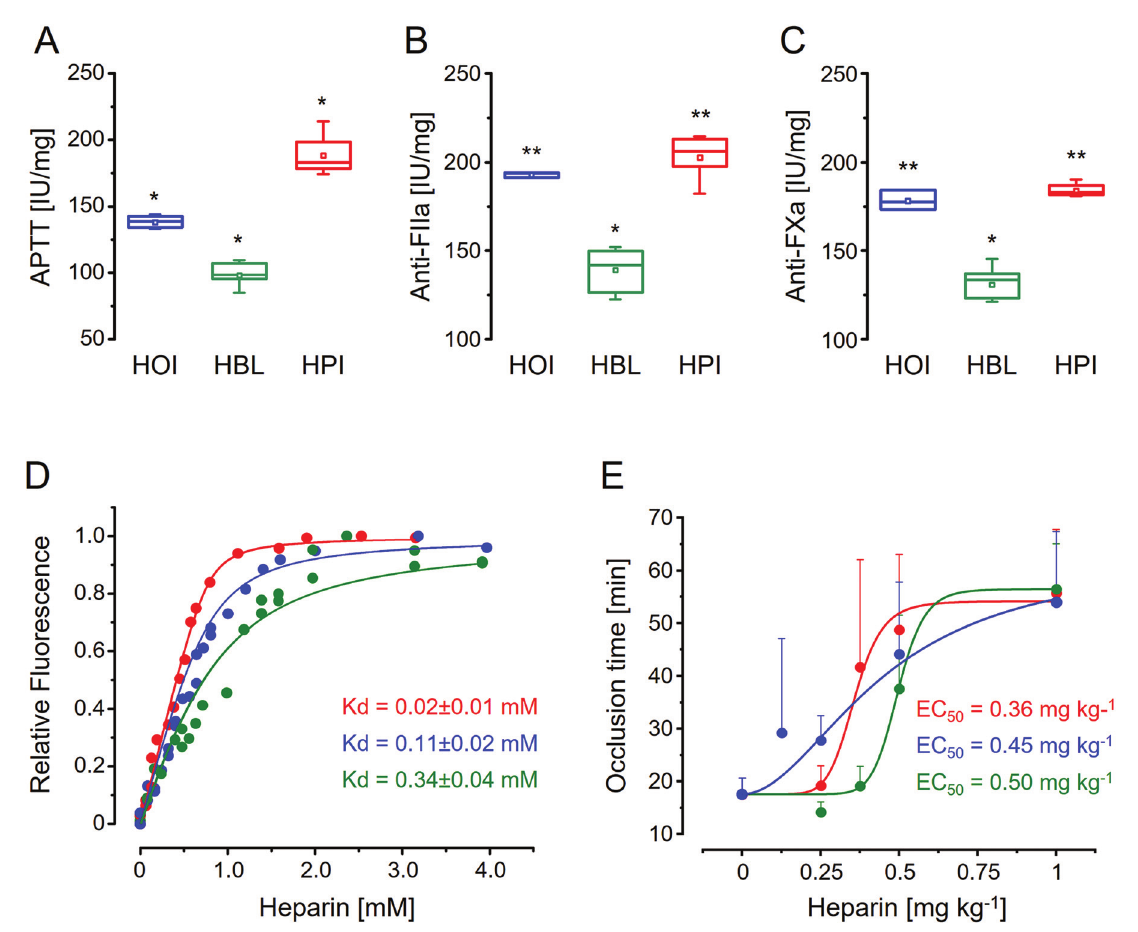
Fig. 7 Heparins obtained from different source have distinct anticoagulant and/or antithrombotic activities. APTT (A), anti-FIIa (B) and anti-FXa (C) assays of HOI, HBL and HPI (in blue, green and red, respectively, in all panels). (D) Fluorometric analyses by titration of the different heparins with antithrombin performed to calculate their dissociation constants (K d ). (E) Antithrombotic activities (EC 50 ) of the different heparins in an animal model of venous thrombosis based on the determination of occlusion time of the jugular vein. (cid:1) p < 0.05 and (cid:1)(cid:1) p > 0.05 (ANOVA with Bonferroni post hoc